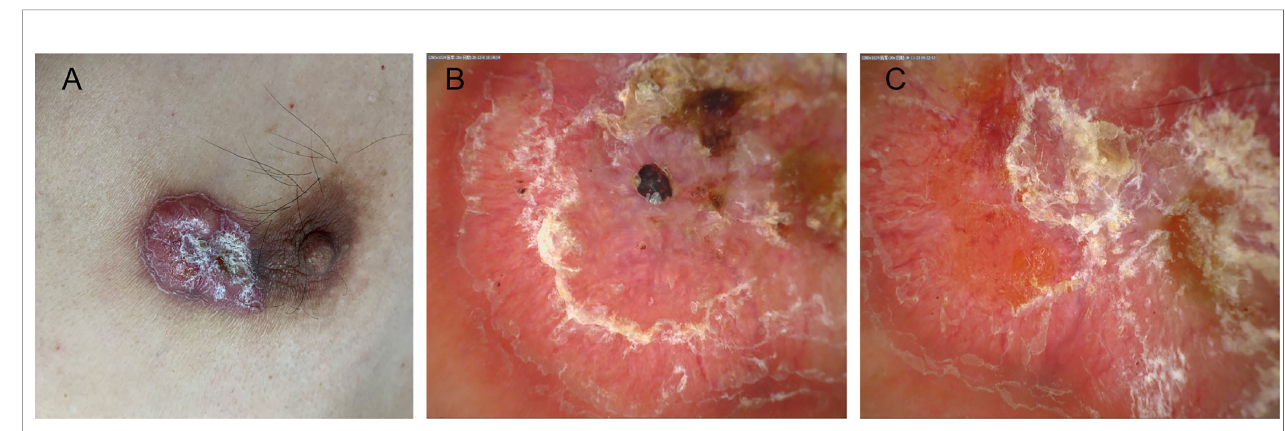
FIGURE 1 | (A) An irregular plaque with a scab on the inside of the left nipple. (B, C) The dermoscopic fi ndings included a bright red background, apparent central keratosis with erosion and blood scabs, and tortuous dilation of peripheral dendritic vessels at the edge